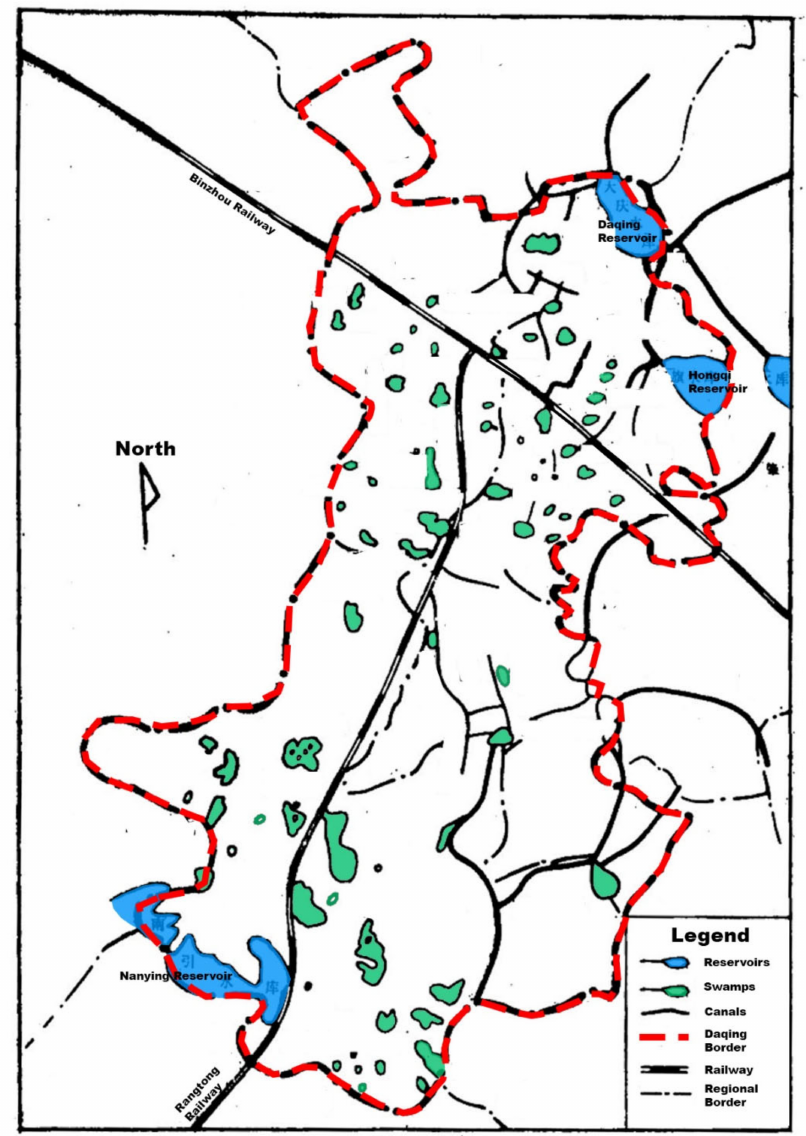
Figure 2. Distribution of Reservoirs and Swamps in Daqing 1989; Source: The Editorial Group of Daqing Land and Resources, modified by Penglin